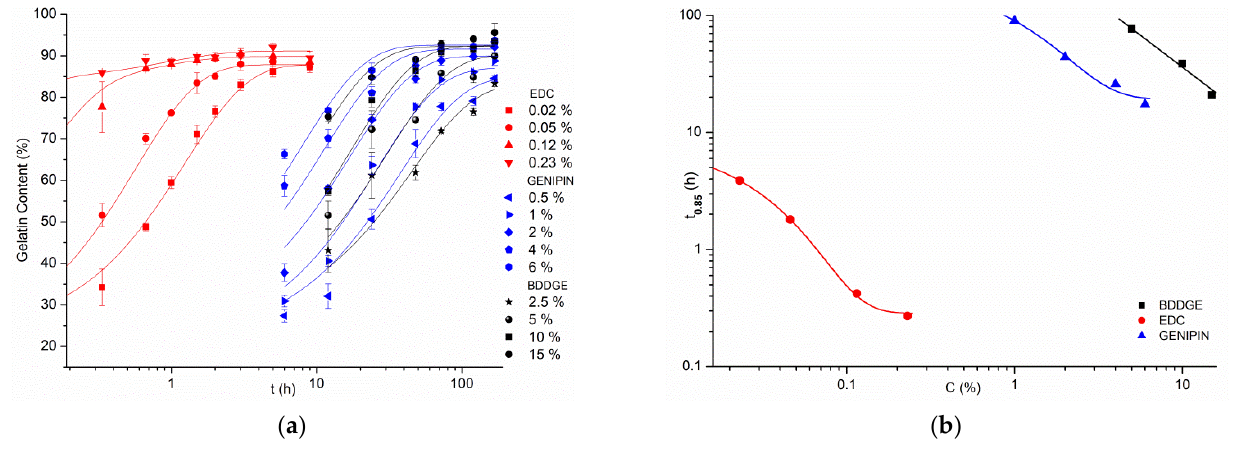
Figure 6. Graphs combining crosslinking results from all experiments: ( a ) gelatin content after biodegradation test, ( b ) f ( C ) = t 0.85 using logarithmic scales. For EDC/NHS, only EDC concentrations are mentioned, in order not to reduce transparency of the graphs.